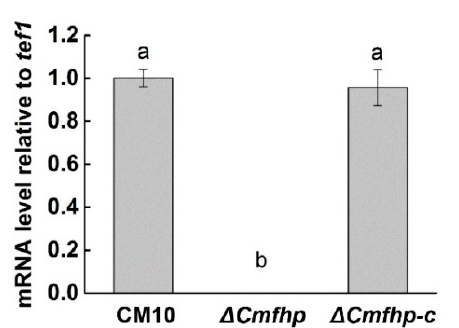
Figure 2. qRT-PCR analysis of the relative expression of the Cmfhp gene in C. militaris transformants using wild-type C. militaris CM10 as a control. Different letters (a,b) indicate significant differences in the relative expression levels of the Cmfhp gene.